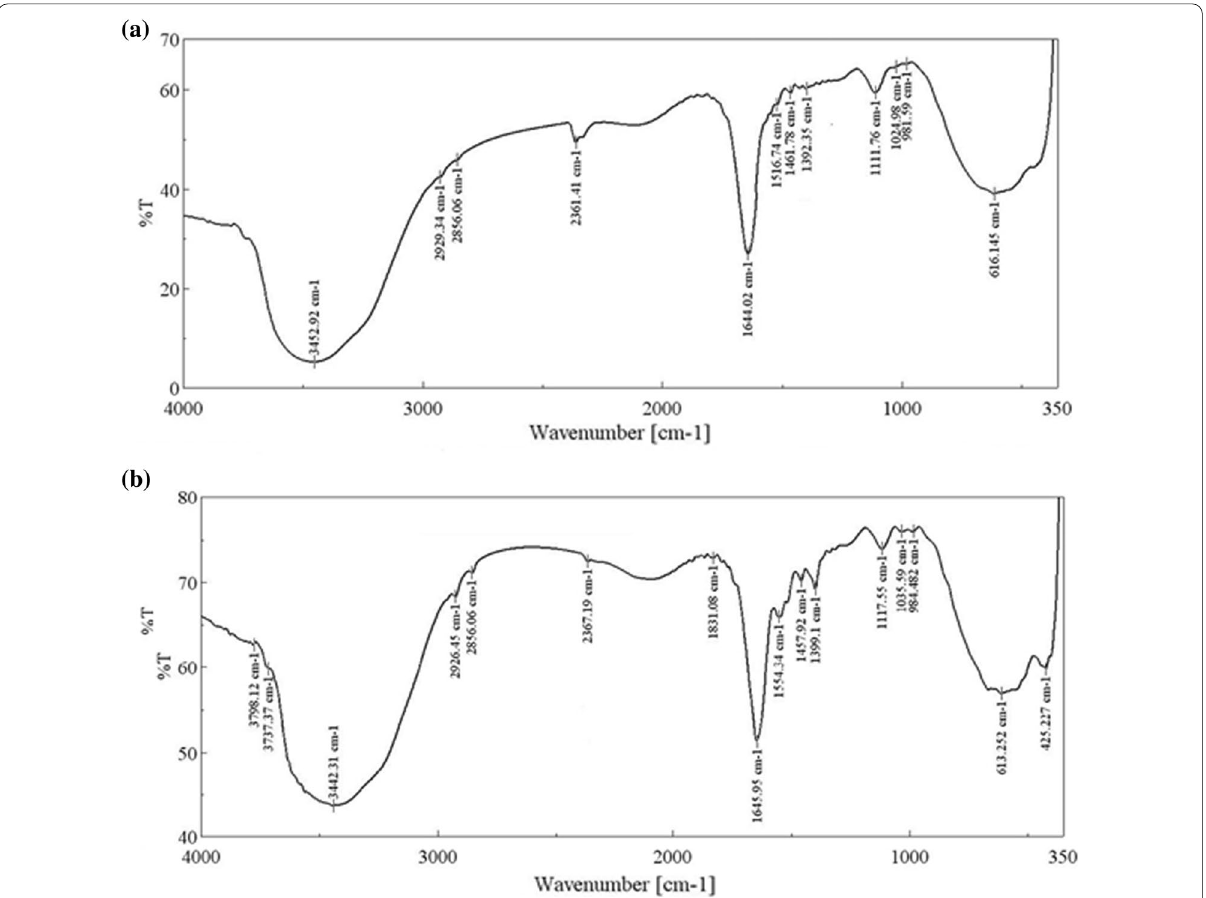
Fig. 2 FTIR spectroscopy, a FTIR diagram of PC, b FTIR diagram of